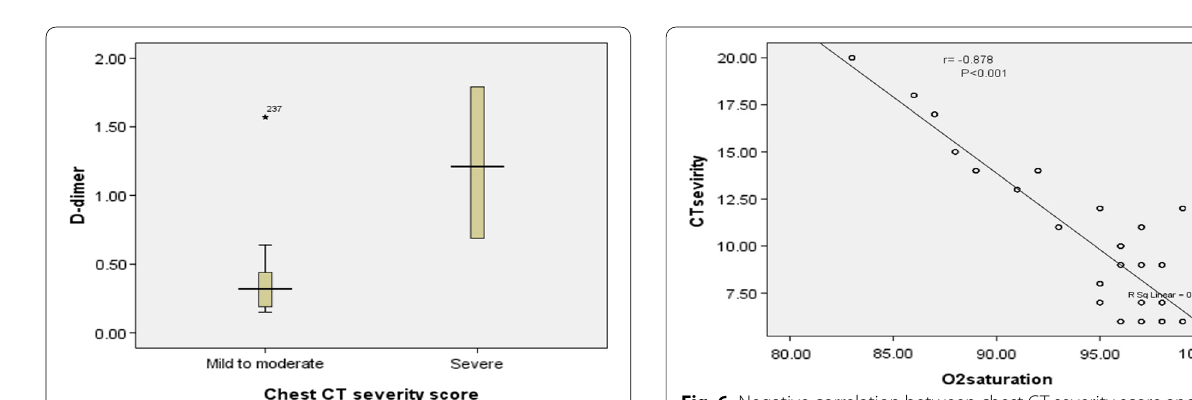
This table shows that blood oxygen saturation level and absolute lymphocytic count was statistically significantly higher among cases with mild to moderate CT severity index, while D-dimer, CRP and ferritin level was statistically significantly higher among cases with severe chest CT severity score HS: P value < 0.001 is high significant